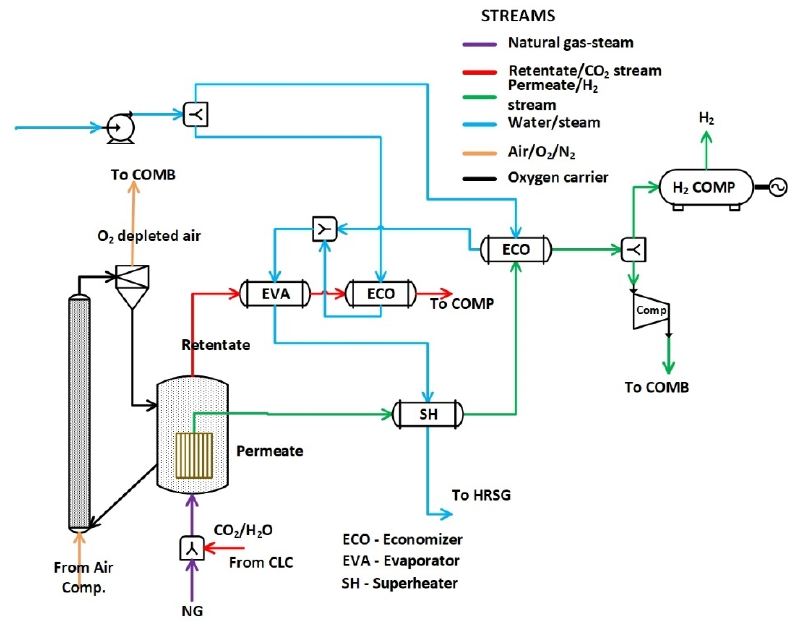
Figure 5. Schematic of case 3 (only MA-CLR is shown).